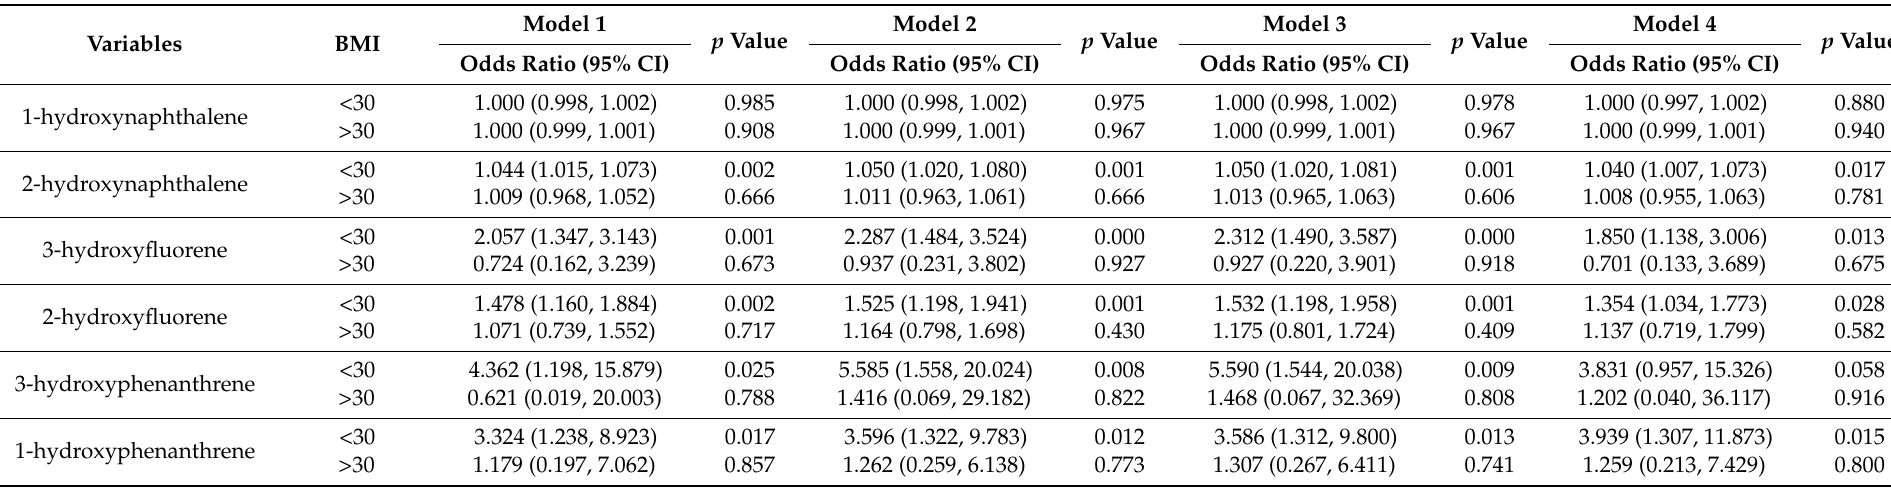
Table 5. Association between PAHs and diarrhea divided by